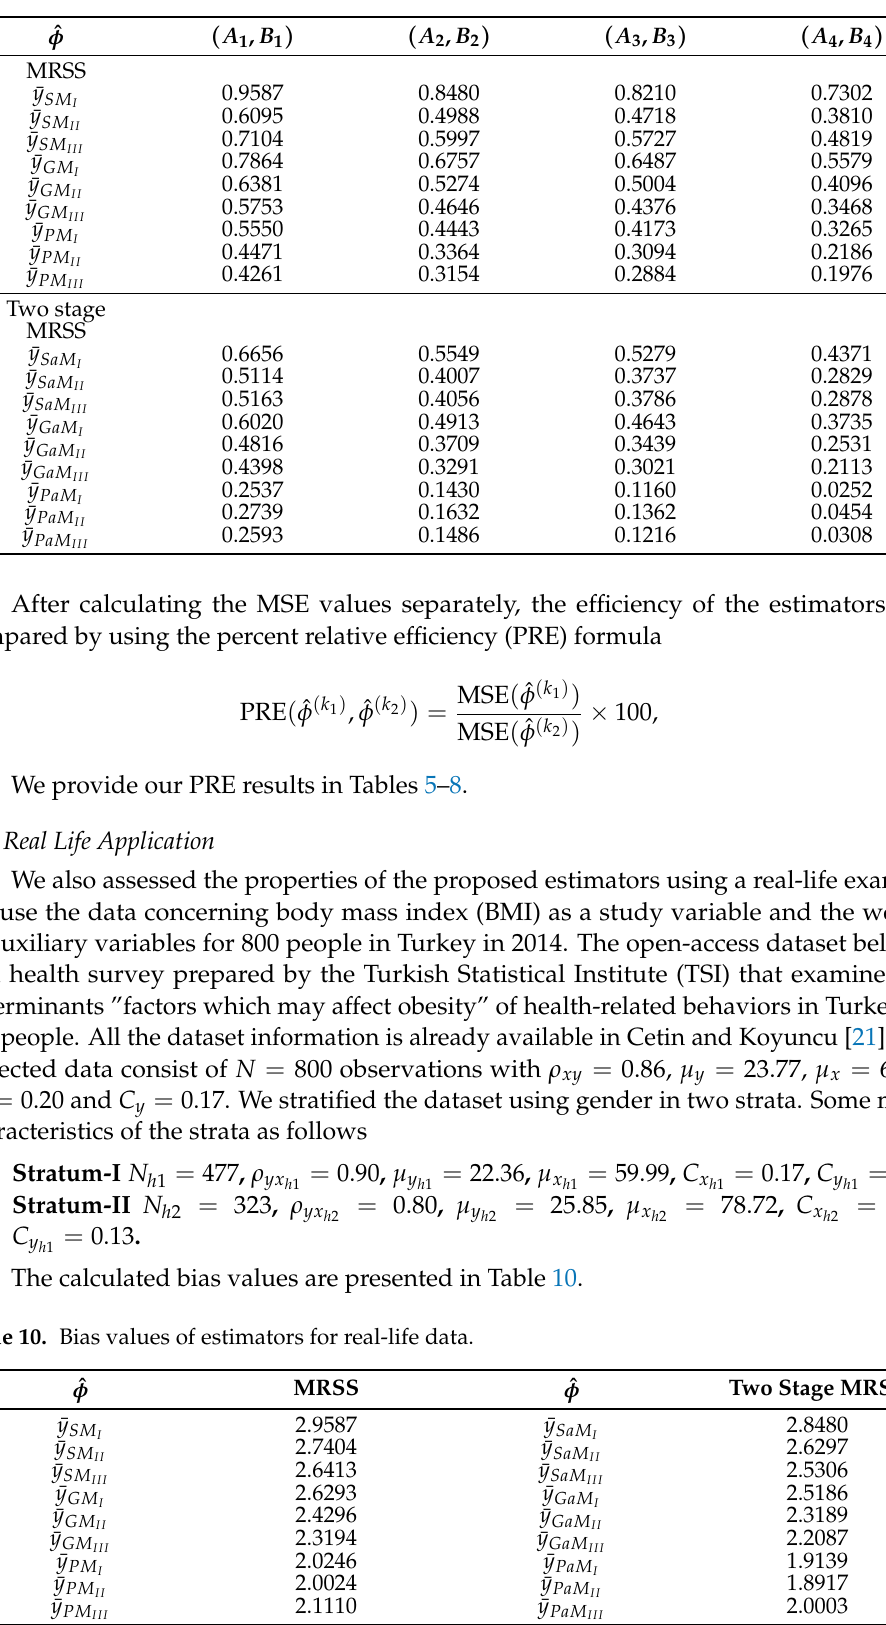
Table 9. Bias values of estimators for simulation study.